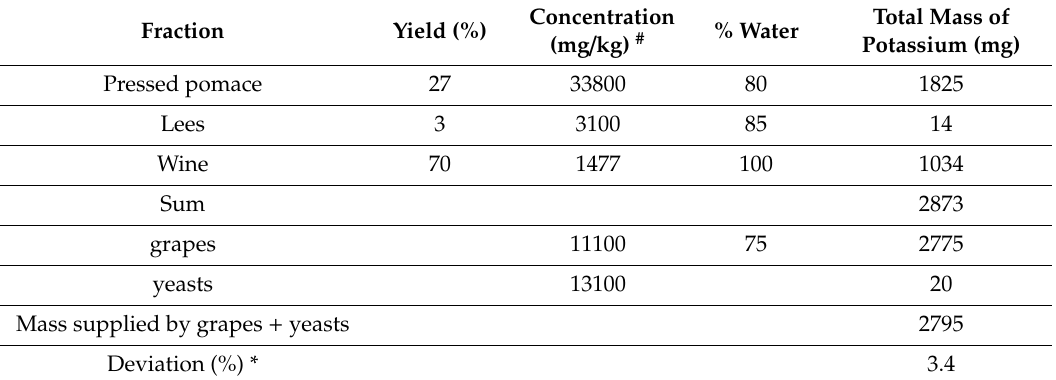
Table 4. Mass balance for potassium #.